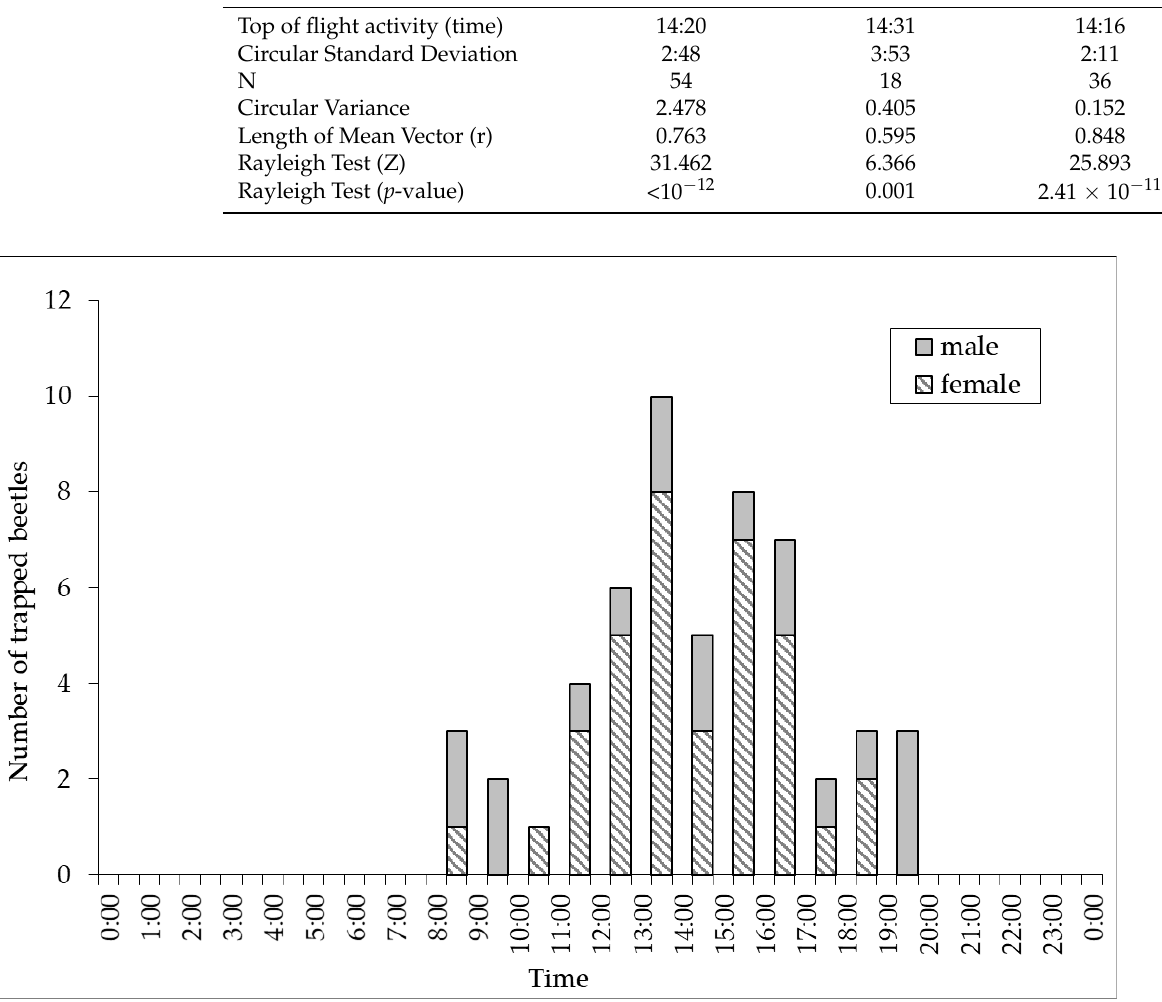
Figure 3. Diurnal flight activity recorded by window traps in period 21–23 May–June 2013 . Table 1. Results of diurnal flight activity for the species, and separately for males and females (2013).